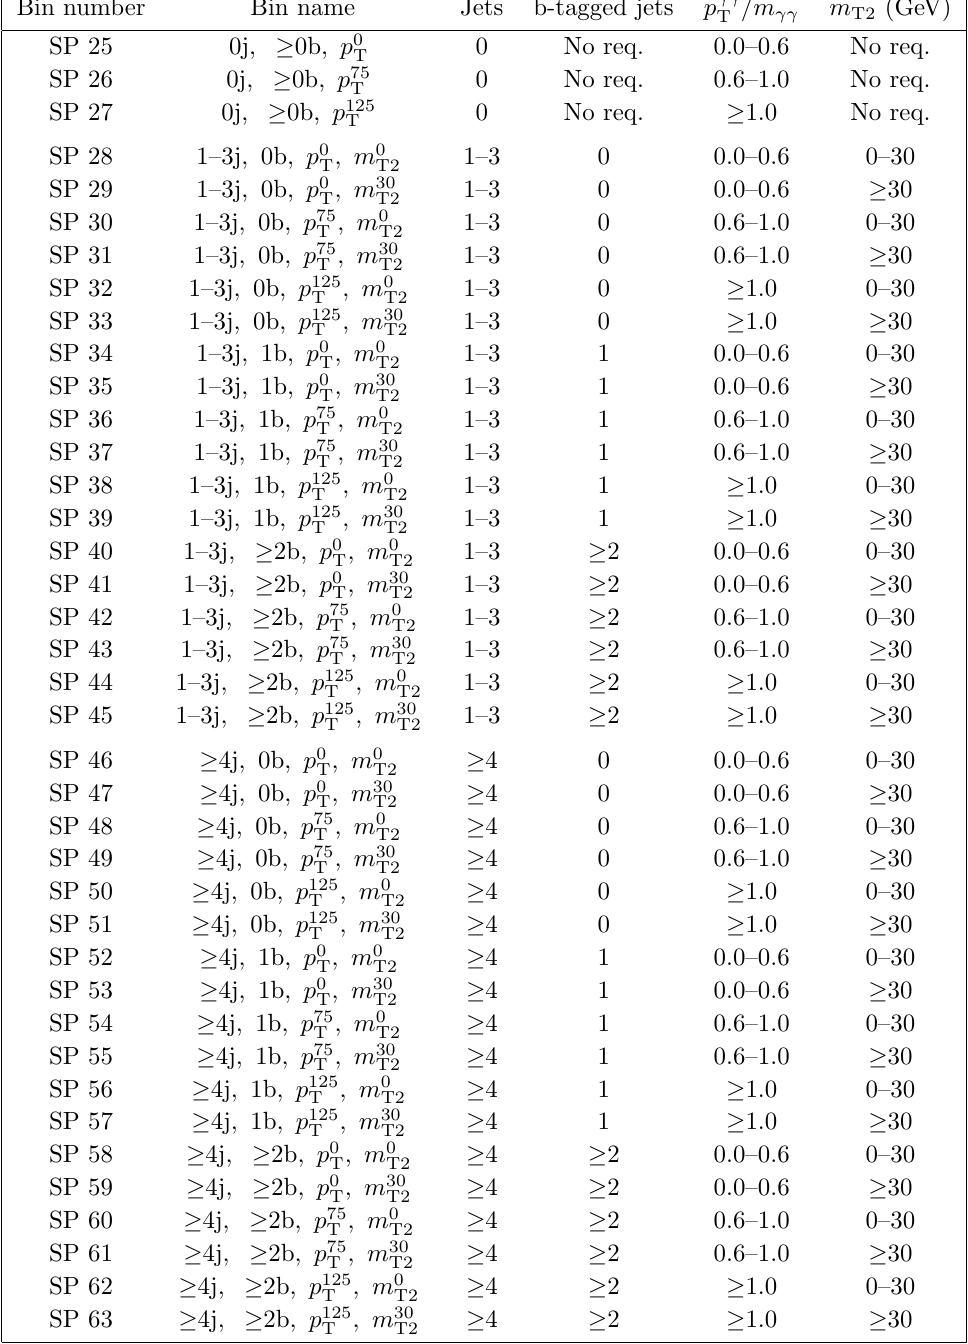
Table 3 . A summary of the search region bins in the leptonic and Higgs boson categories used in the SP analysis, along with the requirements on p (cid:13)(cid:13) requirements are placed on the given